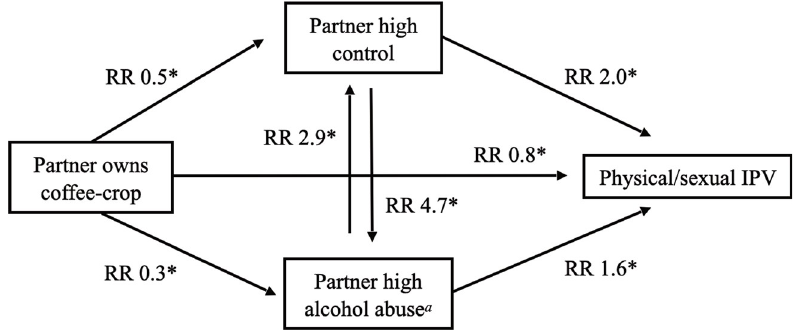
Fig 2. Associations between partner coffee-crop ownership, high control, high alcohol abuse and IPV. Fig 2 illustrates the bivariate associations between partner coffee crop ownership, high control, alcohol abuse and IPV. a High alcohol abuse was compared to none, low and moderate alcohol abuse, � p <